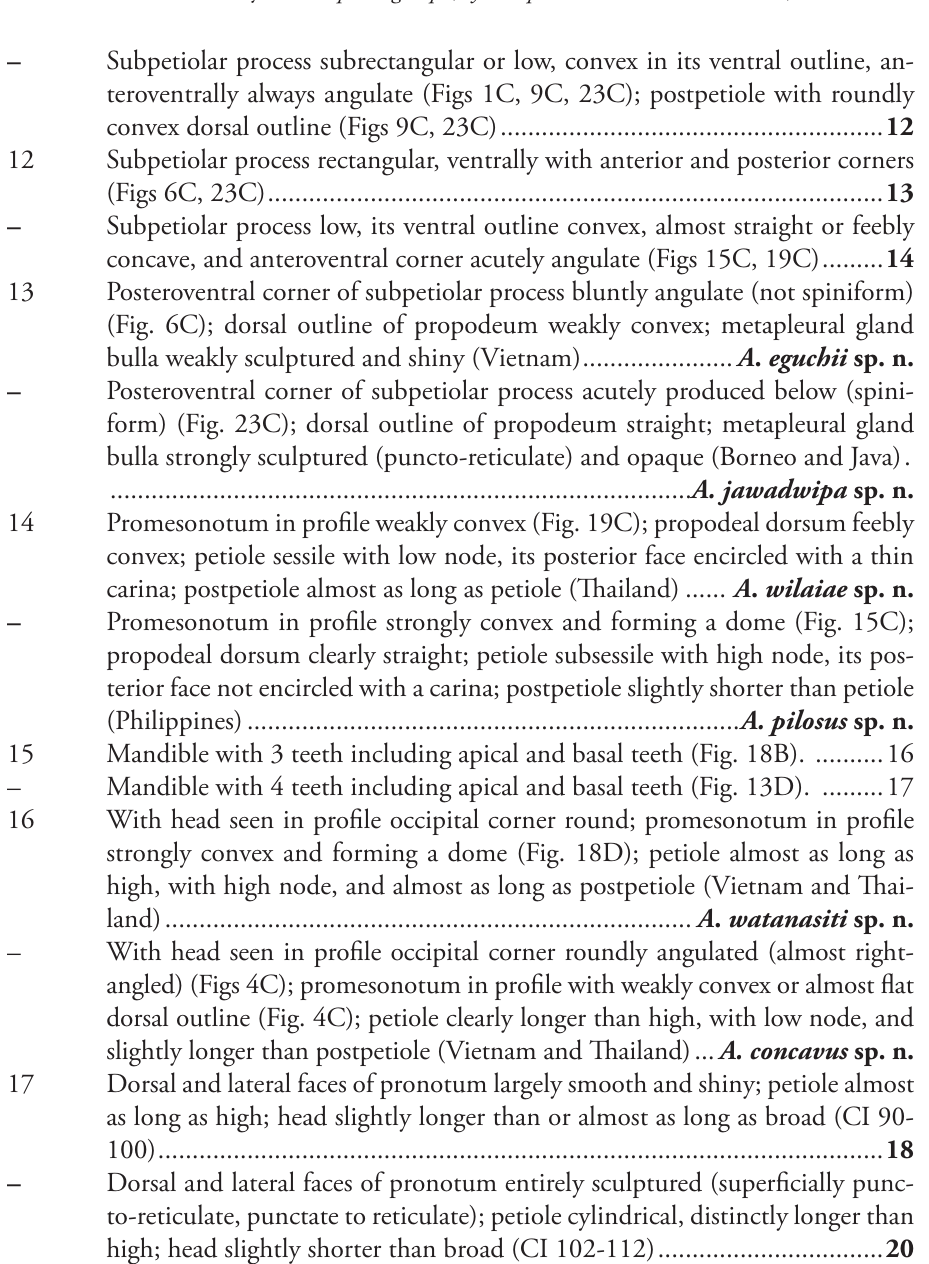
– Subpetiolar process subrectangular or low, convex in its ventral outline, an- teroventrally always angulate (Figs 1C, 9C, 23C); postpetiole with roundly convex dorsal outline (Figs 9C, 23C) ........................................................ 12 12 Subpetiolar process rectangular, ventrally with anterior and posterior corners (Figs 6C, 23C) .......................................................................................... 13 – Subpetiolar process low, its ventral outline convex, almost straight or feebly concave, and anteroventral corner acutely angulate (Figs 15C, 19C) ......... 14 13 Posteroventral corner of subpetiolar process bluntly angulate (not spiniform) (Fig. 6C); dorsal outline of propodeum weakly convex; metapleural gland bulla weakly sculptured and shiny (Vietnam) ...................... A . eguchii sp. n. – Posteroventral corner of subpetiolar process acutely produced below (spini- form) (Fig. 23C); dorsal outline of propodeum straight; metapleural gland bulla strongly sculptured (puncto-reticulate) and opaque (Borneo and Java) . ..................................................................................... A. jawadwipa sp. n. 14 Promesonotum in profile weakly convex (Fig. 19C); propodeal dorsum feebly convex; petiole sessile with low node, its posterior face encircled with a thin carina; postpetiole almost as long as petiole (Thailand) ...... A . wilaiae sp. n. – Promesonotum in profile strongly convex and forming a dome (Fig. 15C); propodeal dorsum clearly straight; petiole subsessile with high node, its pos- terior face not encircled with a carina; postpetiole slightly shorter than petiole (Philippines) ........................................................................ A. pilosus sp. n. 15 Mandible with 3 teeth including apical and basal teeth (Fig. 18B). ..........16 – Mandible with 4 teeth including apical and basal teeth (Fig. 13D). .........17 16 With head seen in profile occipital corner round; promesonotum in profile strongly convex and forming a dome (Fig. 18D); petiole almost as long as high, with high node, and almost as long as postpetiole (Vietnam and Thai- land) ............................................................................. A . watanasiti sp. n. – With head seen in profile occipital corner roundly angulated (almost right- angled) (Figs 4C); promesonotum in profile with weakly convex or almost flat dorsal outline (Fig. 4C); petiole clearly longer than high, with low node, and slightly longer than postpetiole (Vietnam and Thailand) ... A. concavus sp. n. 17 Dorsal and lateral faces of pronotum largely smooth and shiny; petiole almost as long as high; head slightly longer than or almost as long as broad (CI 90- 100) .......................................................................................................... 18 – Dorsal and lateral faces of pronotum entirely sculptured (superficially punc- to-reticulate, punctate to reticulate); petiole cylindrical, distinctly longer than high; head slightly shorter than broad (CI 102-112) ................................. 20 18 Anterior clypeal margin distinctly concave; metanotal groove distinct, deep; foretibia relatively short, its length less than 0.5 times of head width; meso- pleuron finely punctate without longitudinal rugulae (N. Vietnam) ............. ..................................................................................... A . brevipodus sp.